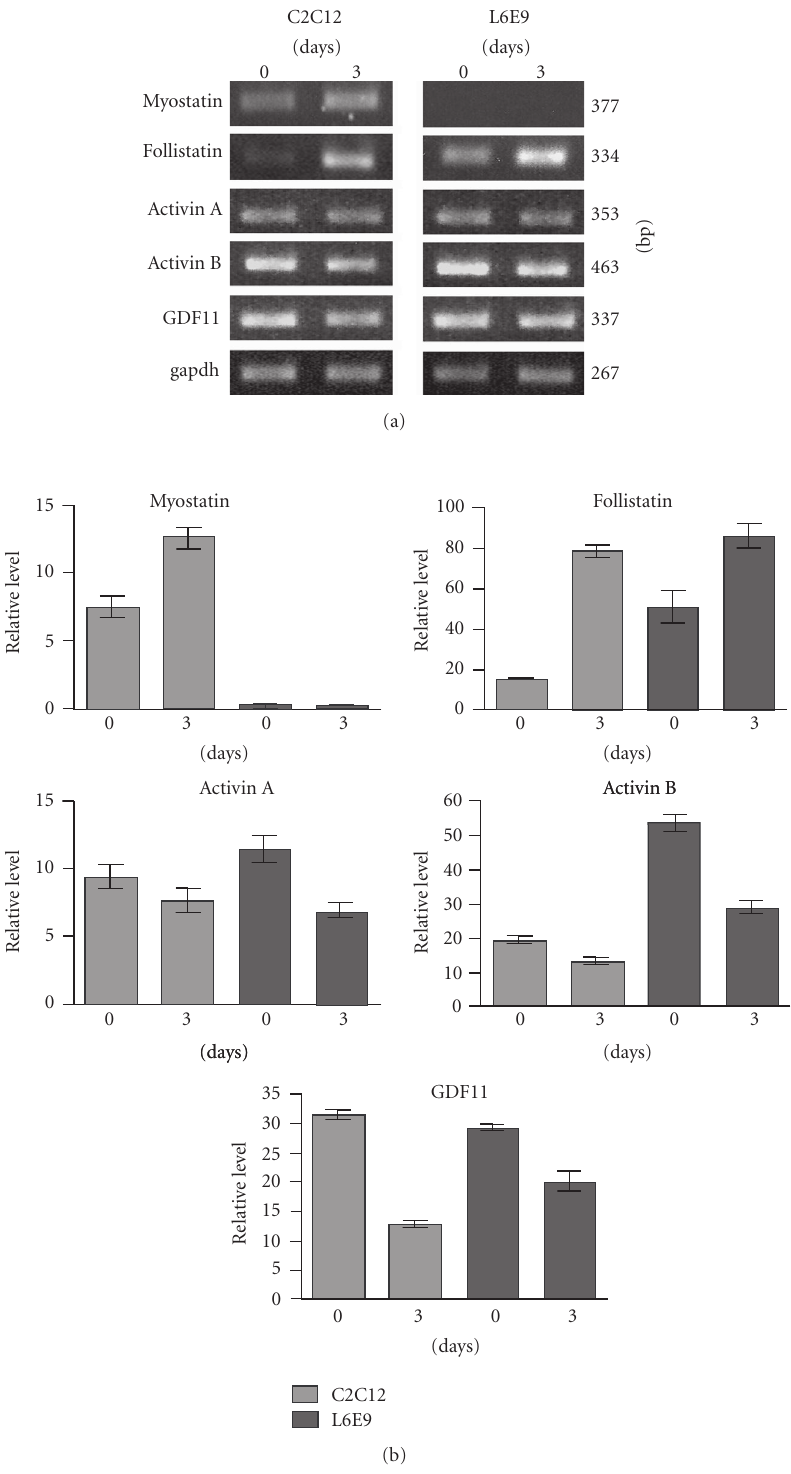
Figure 4: (a) Semiquantitative RT-PCR analysis was carried out to detect the transcript levels of myostatin, follistatin, Activins A and B, and GDF11 in C2C12 and L6E9 myoblasts, undi ff erentiated (day 0) or di ff erentiated (day 3). (b) The graphs compare the relative expression levels of each transcript between C2C12 and L6E9 myoblasts, undi ff erentiated (day 0) and di ff erentiated (day 3), as obtained after normalization with gapdh ( n =